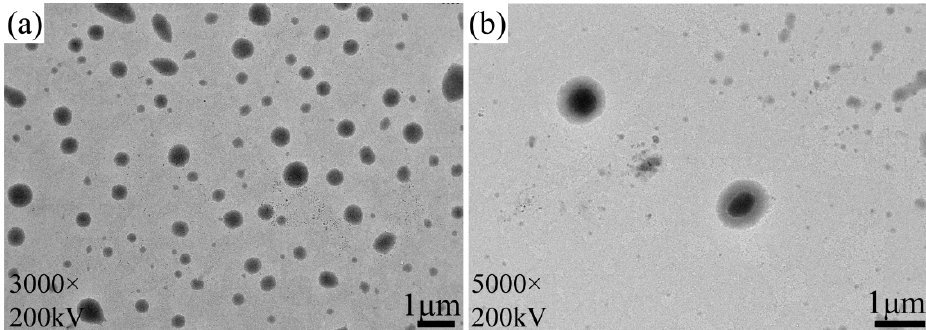
Figure 1. TEM image of WPUA colloidal particles. ( a ) TEM image of WPUA colloidal particles at 3000× magnification. ( b ) TEM image of WPUA colloidal particles at 5000× magnification.